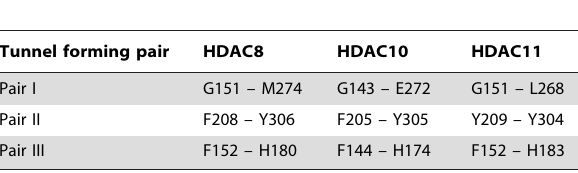
Table 1. Tunnel forming residues of three different isoforms HDAC8, HDAC10, and